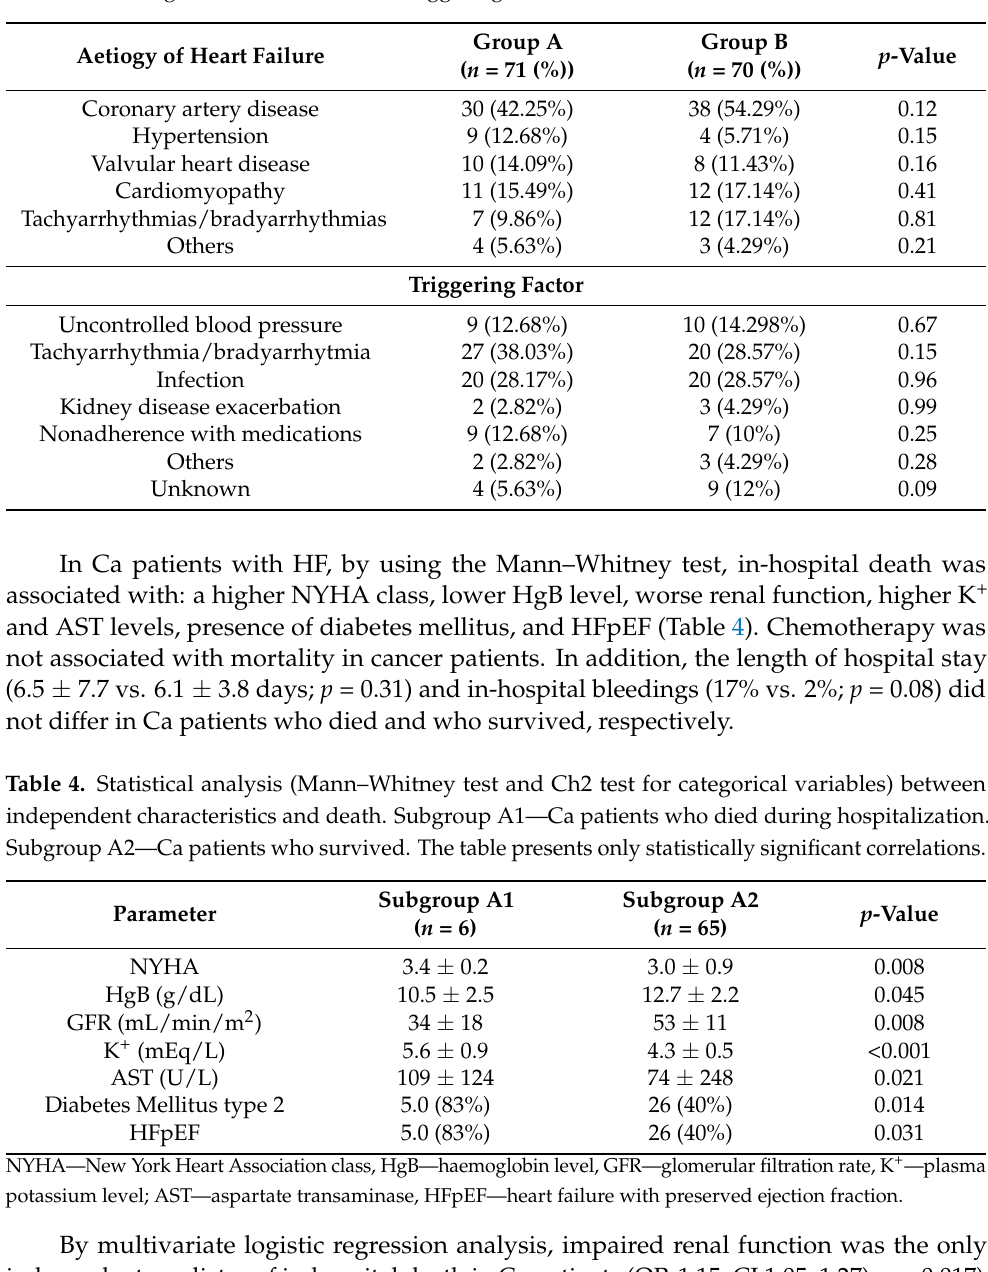
Table 3. Aetiologies of heart failure and triggering factors of its exacerbation.